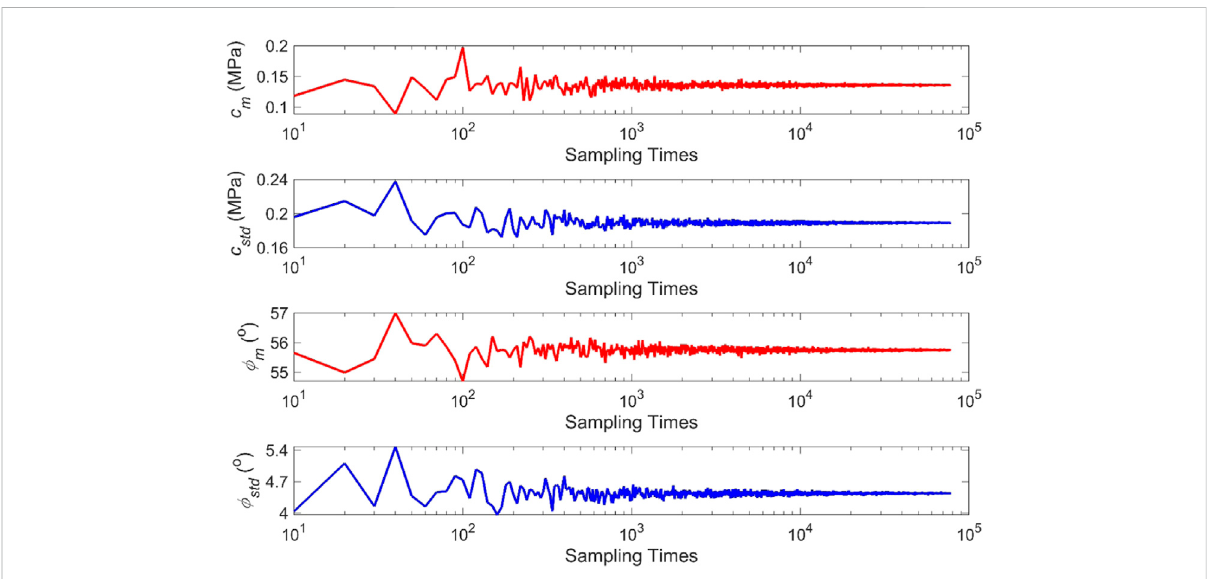
FIGURE 9 Meanandstandarddeviationoftheapparent c and φ astheMCStimeincreases( c m and c std arerespectivelythemeanandstandarddeviationof c ; and, ϕ m and ϕ std are respectively the mean and standard deviation of φ ).